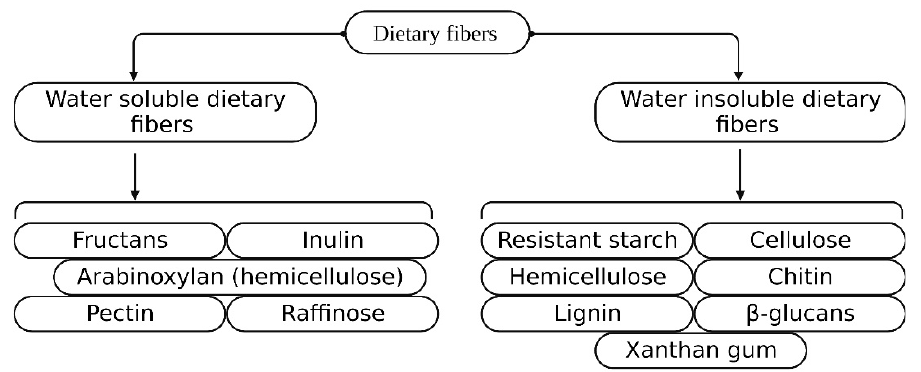
Figure 1. Dietary fiber classification based on water solubility/insolubility. SCFAs are a sub-class of fatty acids composed of carbon atoms (six or fewer), acetate (C2), propionate (C3), butyrate (C4), pentanoic acid (C5), and hexanoic acid (C6) [20].